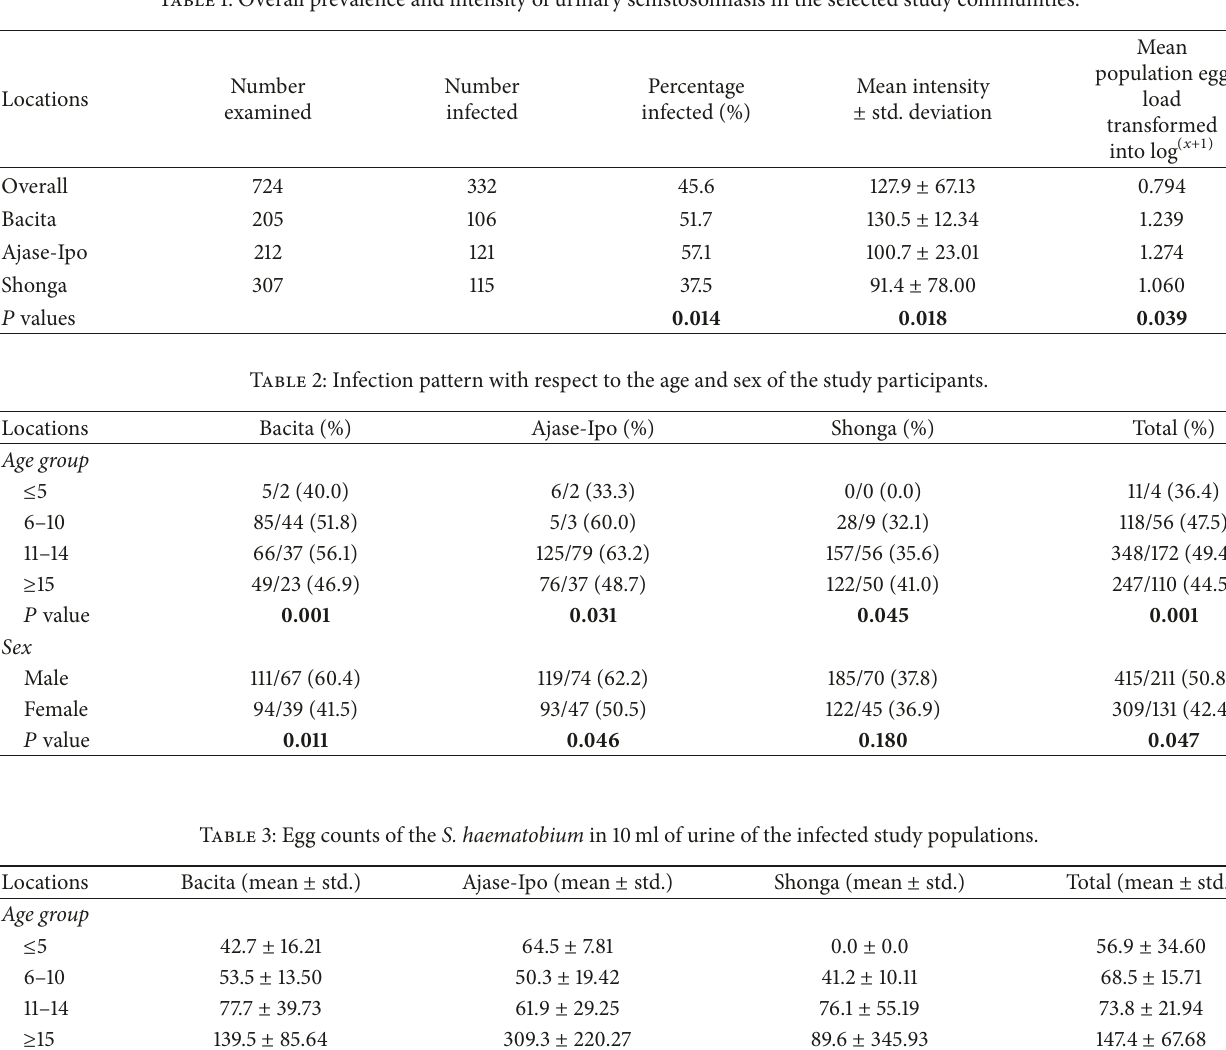
Table 1: Overall prevalence and intensity of urinary schistosomiasis in the selected study communities.